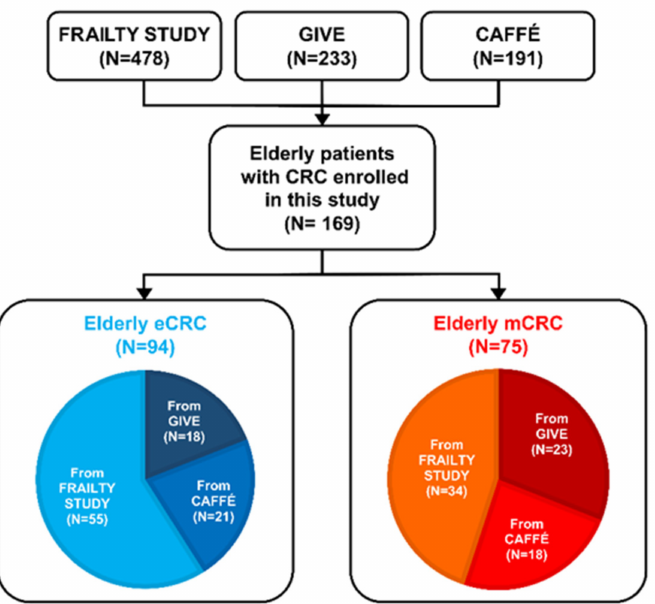
Figure 1. CRC patients enrolled in this study were divided in eCRC and mCRC according to the disease stage. Serum samples were pooled among three clinical trials (Frailty Study, GIVE, and CAFF É ). The number of samples coming from each study is also